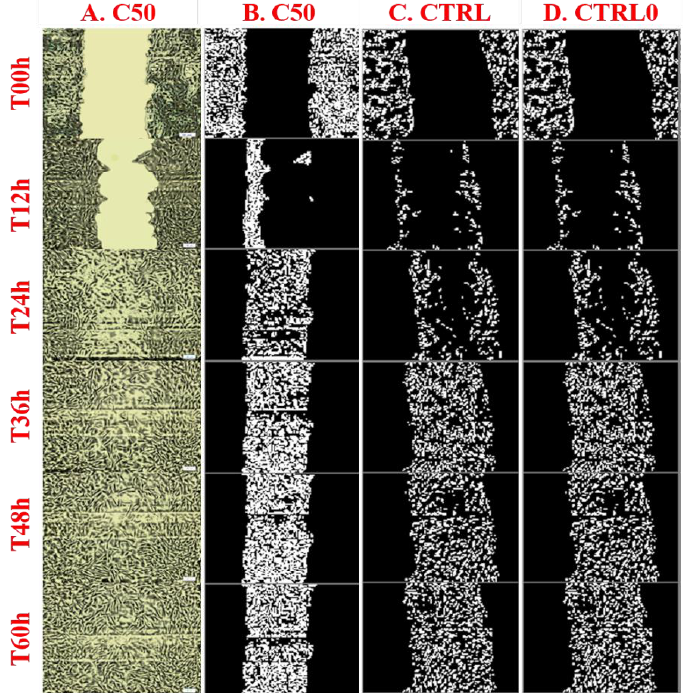
Figure 2. Spontaneous migration of dermal fibroblasts and evolution of “gap’’ closure in time: Col- umn A — C50, original images of fibroblasts treated with EOT (50 µg/mL), objective 20×; Column Column A —C50, original images of fibroblasts treated with EOT (50 µ g/mL), objective 20 × ; Column B — C50, the same samples, after image processing; Column C — CTRL, fibroblasts treated with 50 B —C50, the same samples, after image processing; Column C —CTRL, fibroblasts treated with µg/mL allantoin, after image processing; Column D — CTRL0, treatment-free fibroblasts. 50 µ g/mL allantoin, after image processing; Column D —CTRL0, treatment-free